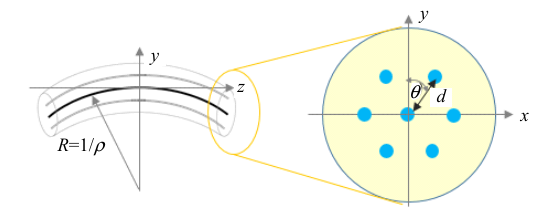
Fig. 1 Schematic diagram of 7-core optical